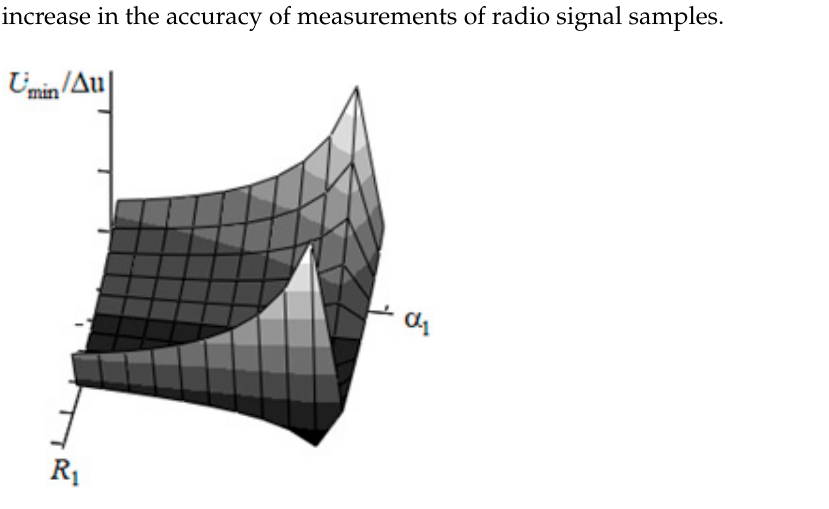
75,...,95 α= ° and 0.005,...,0.015 R = m 1 1